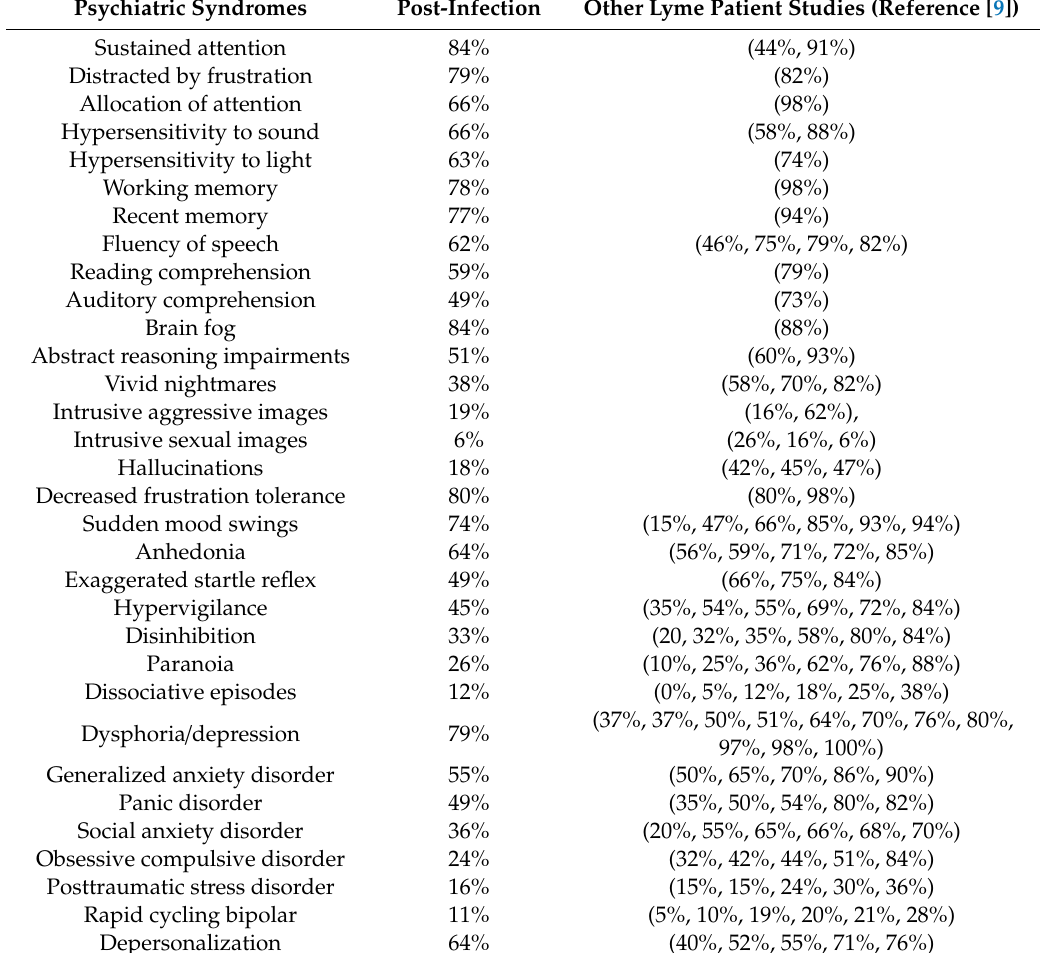
Table 4. Post-infection findings compared to the prevalence of the same findings in other